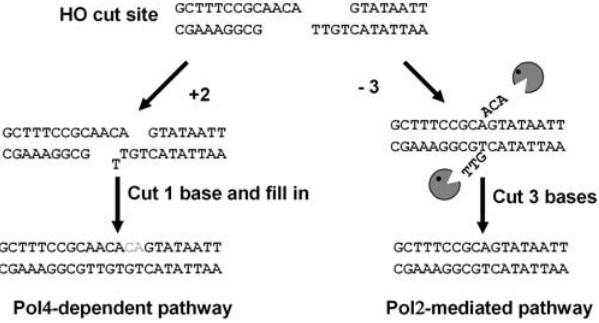
Figure 4. Proposed pathways for imprecise end joining of the HO endonuclease induced DSB at MATa . The 4-bp 3 9 overhanging sequence resulting from HO endonuclease cleavage is indicated. The two ends must be brought together into synapsis. Precise religation would lead to re-cutting. Possible end processing and subsequent alignment of complementary base pairs that would lead to insertions or deletions are shown. When 3 9 overhangs mispair, Pol4 is required to fill in the gap [15,16]. When 3 9 flaps are generated by mis-alignment, the 3 9 to 5 9 exonuclease activity of Pol2 is the predominate exonuclease to remove the